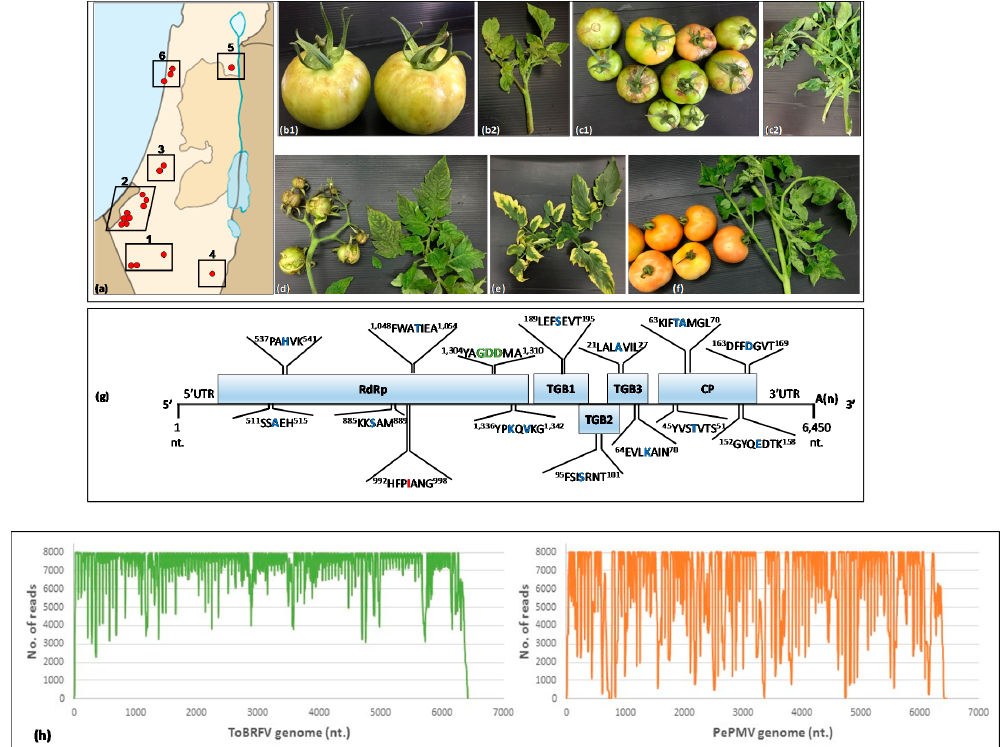
Figure 1. New severe symptomatic tomato plants observed in tomato-growing plots widely spread in Israel showed mixed infections with pepino mosaic virus (PepMV) and tomato brown rugose fruit virus (ToBRFV-IL). ( a ) A geographical scheme of the tomato-growing sites in Israel affected by the new disease symptoms: 1, Ramat Negev; 2, Bsor; 3, Lakhish; 4, Arava; 5, Beit She’an Valley; 6, Hefer Valley. ( b )–( f ) Symptomatic tomato plants. ( b1 ) Brown rugose spots on unripe fruits. ( b2 ) Mild mottling on leaves. ( c1 ) Scarred and open unripe fruits. ( c2 ) Leaf narrowing. ( d ) Open undeveloped fruits and interveinal chlorosis on leaves. ( e ) Bright yellow patched leaf margins. ( f ) Bright yellow patched and marbled fruits and mosaic on fern leaves. ( g ) A scheme of PepMV genome depicting open reading frames and selected deduced amino acids (aa) shared by all the Israeli isolates (GenBank accession Nos.: MT018444, MT018445, MT018446, MT018447, MT018448, MT018449). Blue-colored aa are characteristic of mild PepMV CH2 strains; a red-colored aa is characteristic of an aggressive PepMV CH2 strain; a green-colored aa triplet is a conserved sequence shared by both aggressive and mild PepMV CH2 strains; RdRp, RNA-dependent RNA polymerase; CP, coat protein. ( h ) High-throughput sequencing of PepMV-Ah isolate and ToBRFV-IL isolate (GenBank accession Nos. MT018444 and KX619418, respectively) found in symptomatic tomato plants collected from Ahituv (Hefer Valley). Read Nos. and depths covering the whole genome of either PepMV or ToBRFV are depicted.